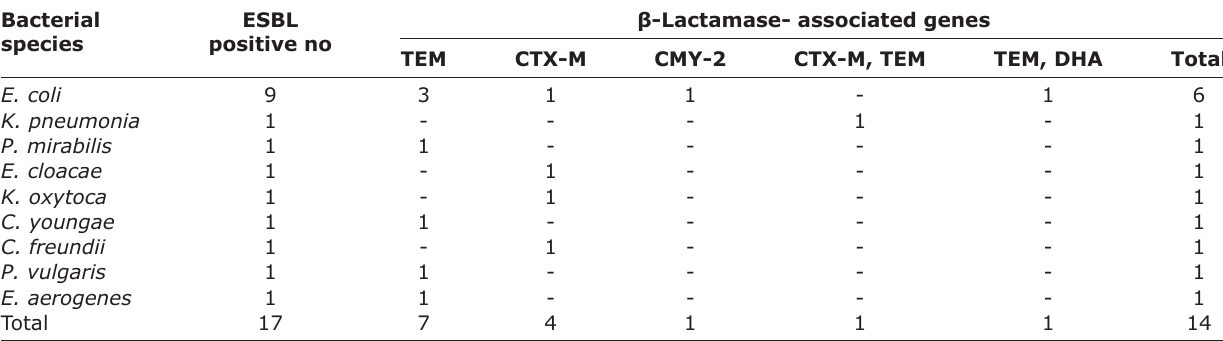
Table-2: Prevalence and multiplicity of β -Lactamase genes among ESBLs- positive fecal bacteria derived from wild pet animals in Saudi Arabia. Bacterial species